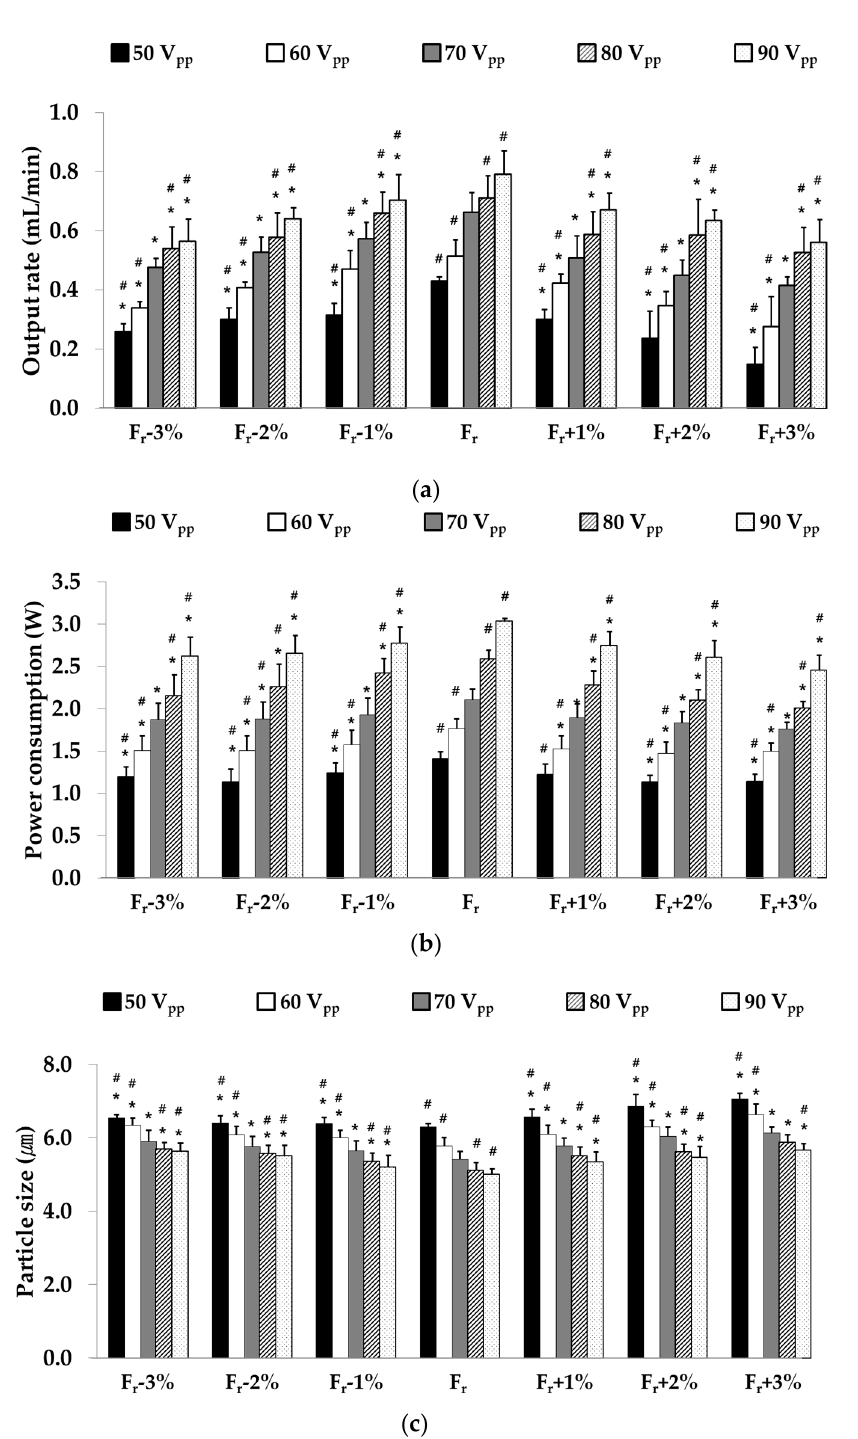
Figure 5. Nebulization characteristics of salbutamol solution by driving frequency and voltage: ( a ) Output rates; ( b ) Power consumptions; ( c ) Particle sizes; All values are means ± SDs, * p < 0.05 versus F r at each driving voltage, # p < 0.05 versus 70 V pp at each driving frequency.